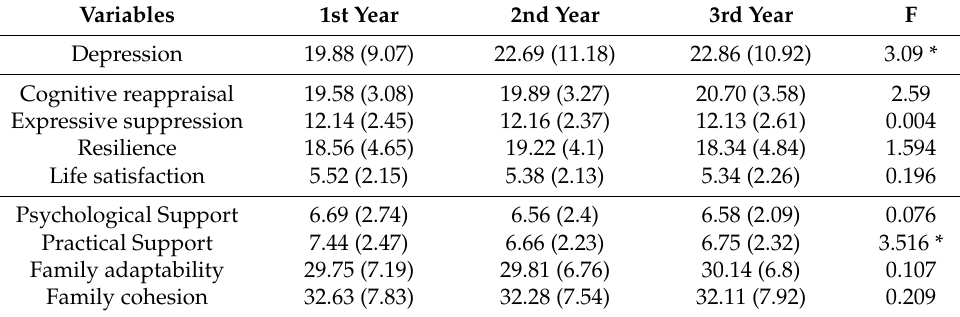
Table 2. Characteristics of variables, mean